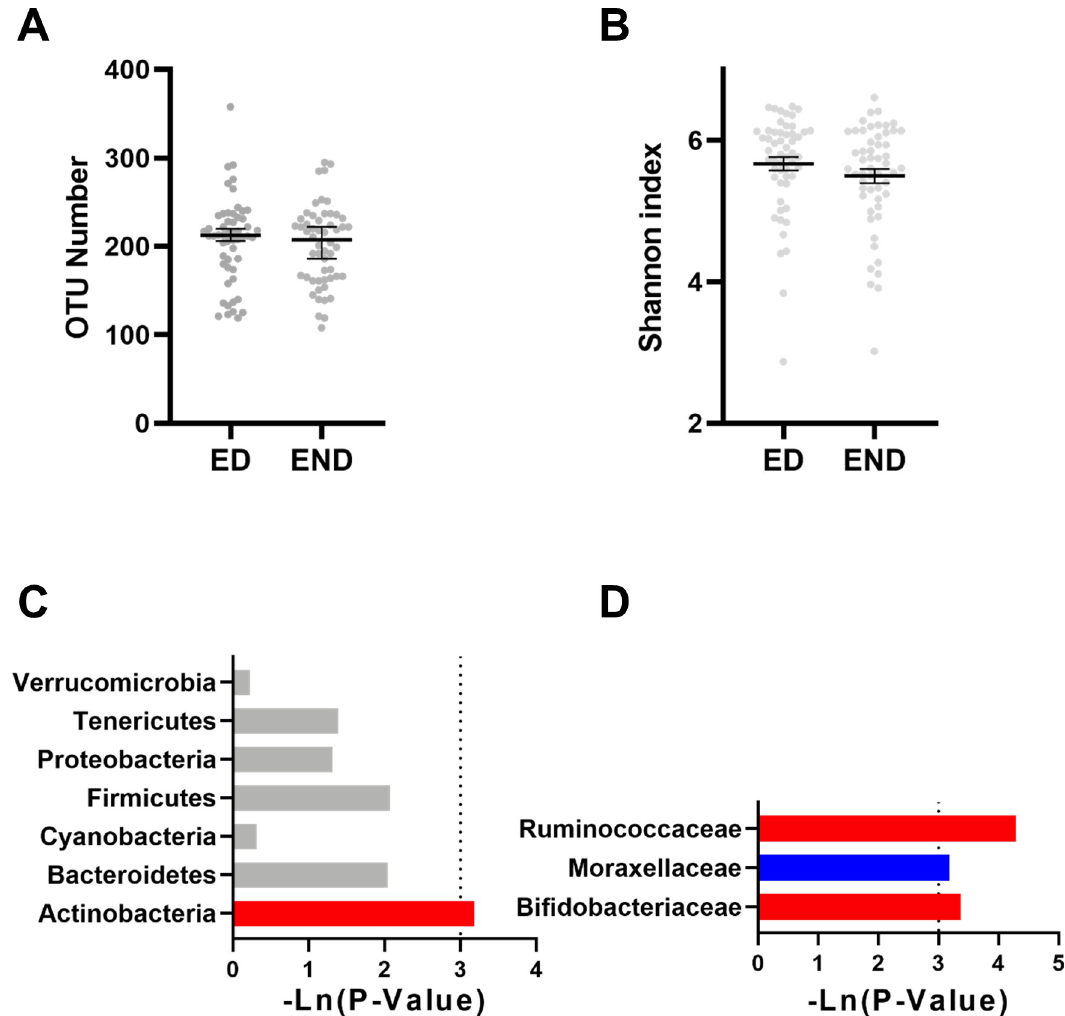
Fig 1. The effect of dog ownership on the microbial composition of elderly individuals. Dog ownership did not affect the (A) number of OTUs or the (B) Shannon index. The effect of dog ownership on bacteria at the (C) phylum level and (D) family level. The red bar represents a significant increase, while the blue bar represents a significant